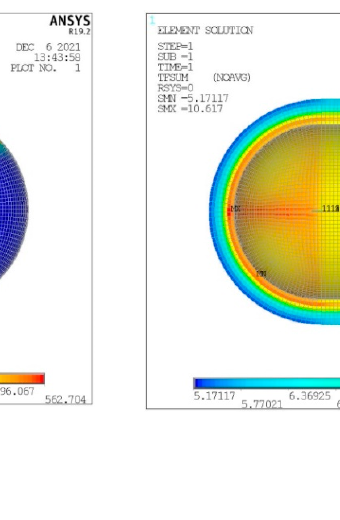
( c ) Figure 10. Heat flux distribution for ( a ) inner aluminum shell, ( b ) insulating material, ( c ) outer composite shell. ( a ) ( b ) Figure 11. Distribution of ( a ) Von Mises stress on the inner aluminum shell and ( b ) Tsai–Wu index on the insulating material.